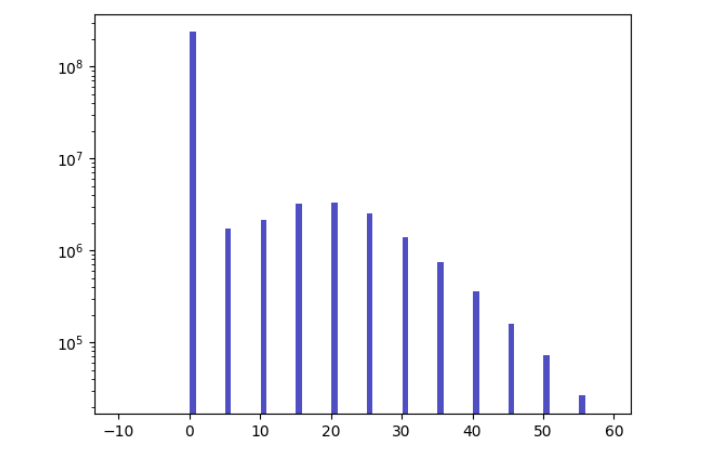
Figure 5. A histogram of the non-missing values in the NMA dataset for the entire region for a whole day, including all acquisitions at all elevations. A logarithmic scale was used on the OY axis.